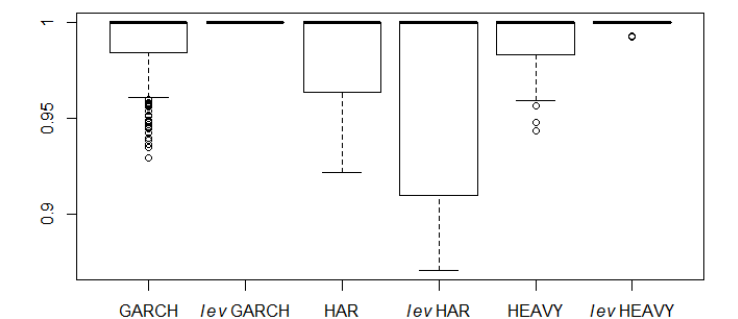
Figure 2. Estimates of the extremal index on the volatility residuals.